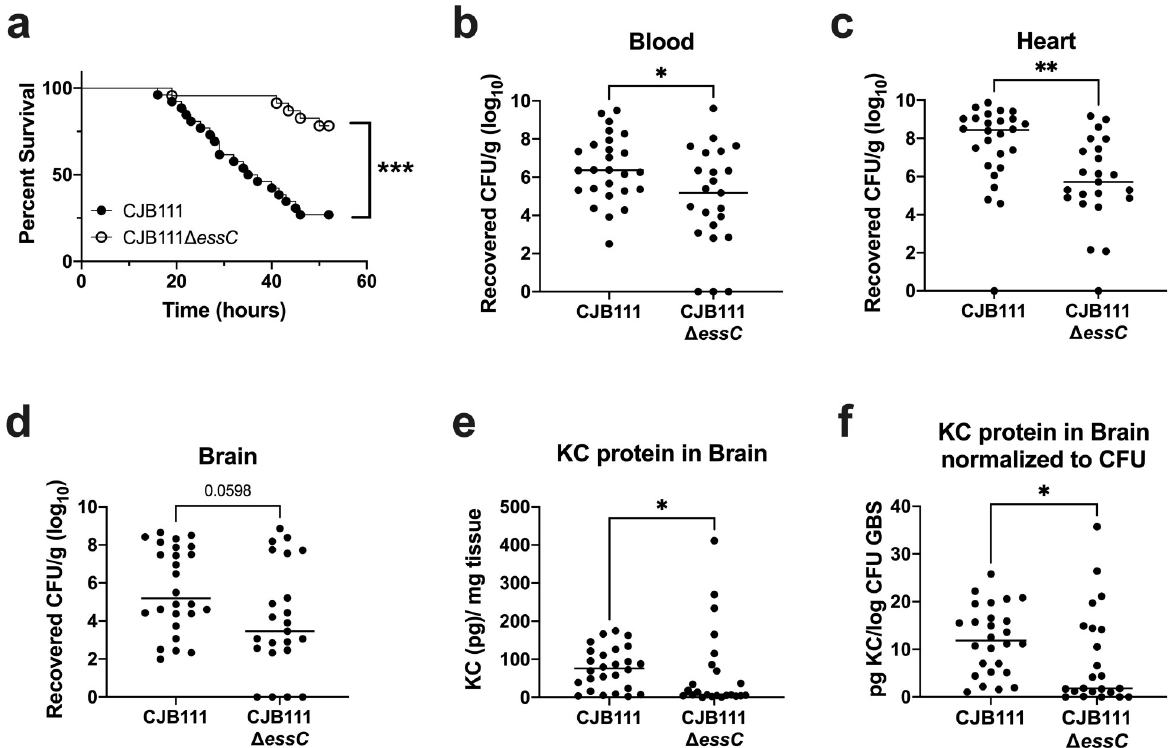
Fig 2. CJB111 T7SS mediates virulence in a model of hematogenous meningitis. a) Survival curve of 8 week-old CD1 male mice tail-vein injected with CJB111 (n = 26) or CJB111 Δ essC (n = 23). Graph shows combined survival curves of three independent experiments, all of which ended at 52 hours post-infection. Statistics reflect the Log rank (Mantel-Cox) test, p < 0.001, ��� . Recovered CFU counts from the b) blood c) heart, and d) brain tissue of infected mice. e) KC protein levels quantified from infected brain tissue by ELISA, and f) normalized to the log 10 CFU within each brain. In panels b-f , each dot represents one mouse and all three independent experiments’ data are combined in these figures. Plots show the median. Statistics represent the Mann Whitney U test. p < 0.05, � ; p < 0.01, �� .